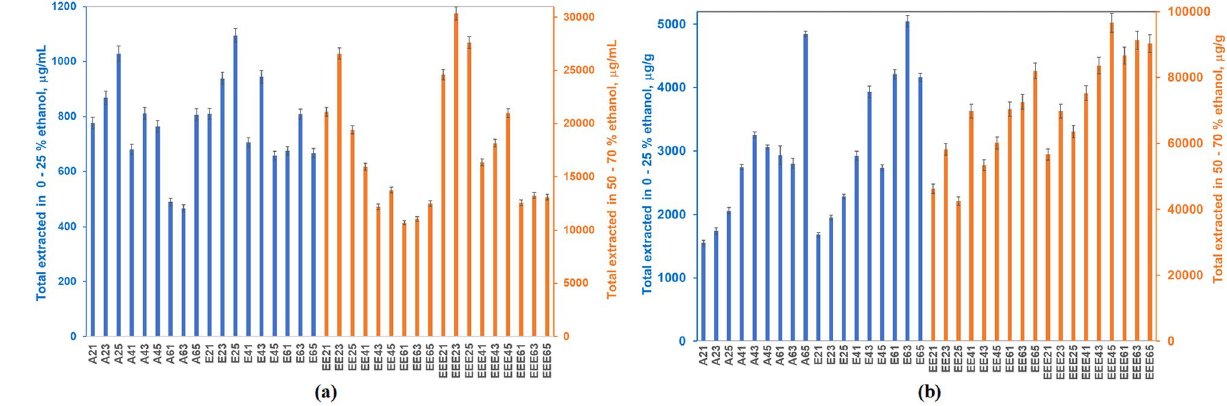
Figure 1. Total extracted polyphenolic acids and flavonoids expressed as ( a ) μ g/mL and ( b ) μ g/g